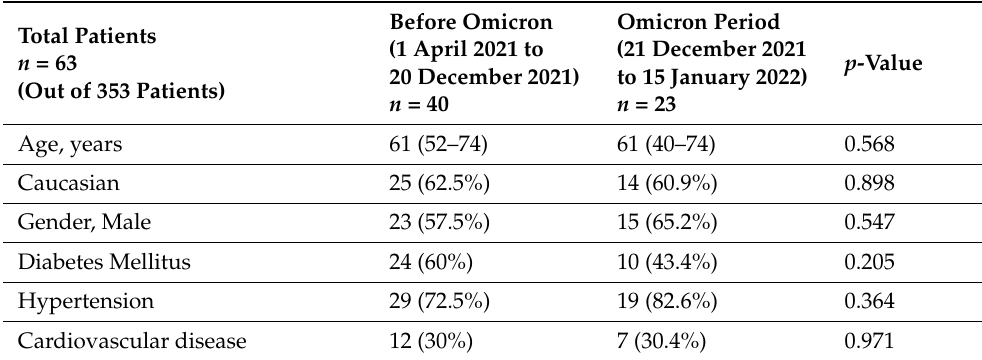
Table 4. Comparison of characteristics of breakthrough infections in vaccinated